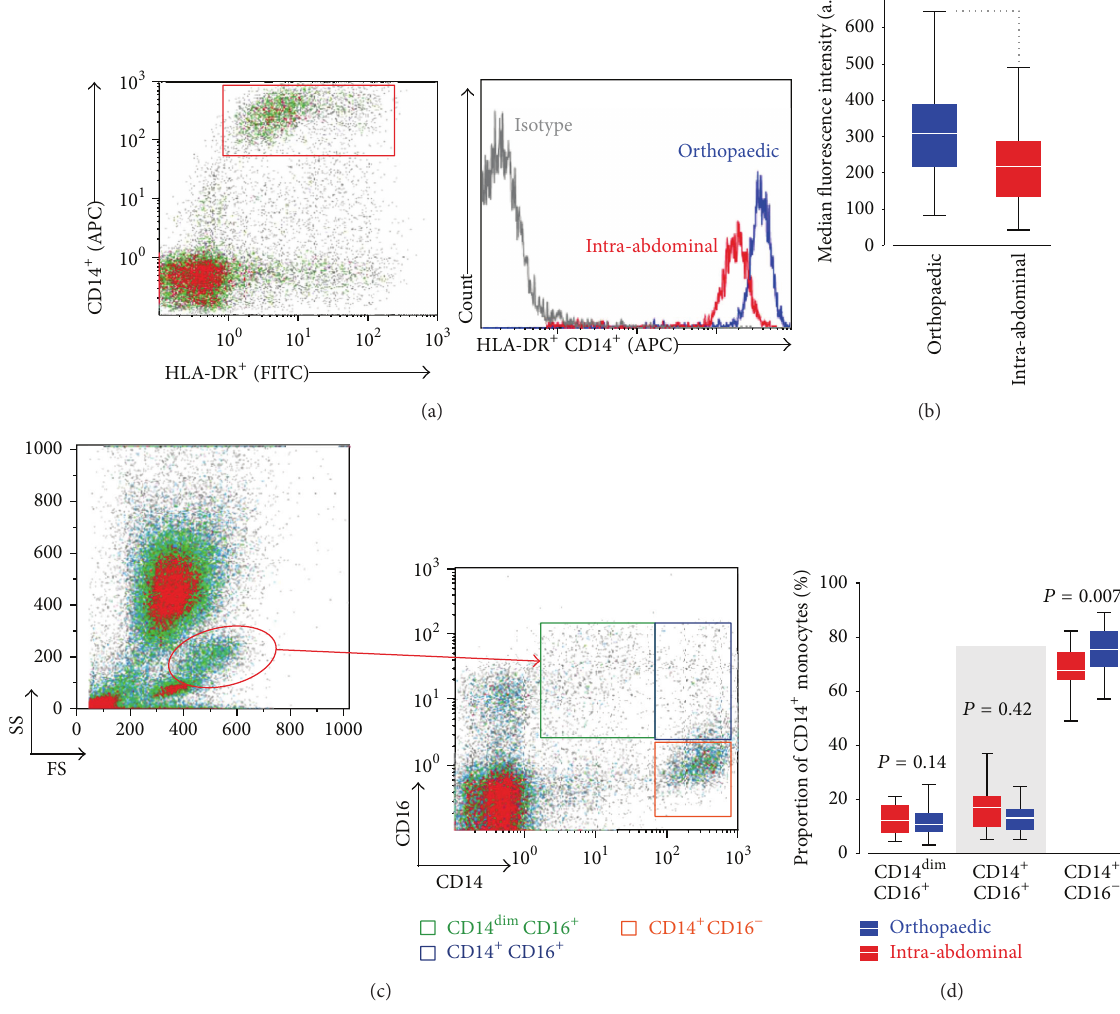
Figure 3: Monocyte CD14 + expression. (a) Representative HLA-DR + CD14 + expression (median fluorescence intensity) in orthopedic (blue) and gastrointestinal (red) surgical patients. Isotype control shown in grey. (b) Summary data for orthopedic ( 𝑛 = 43 patients) and gastrointestinal malignancy ( 𝑛 = 31 patients). (c) Gating strategy to define HLA-DR + CD14 + monocyte subsets, including CD16 + cells. (d) Proportions of monocyte CD14 + subsets according to CD16 + expression. All data are represented as median